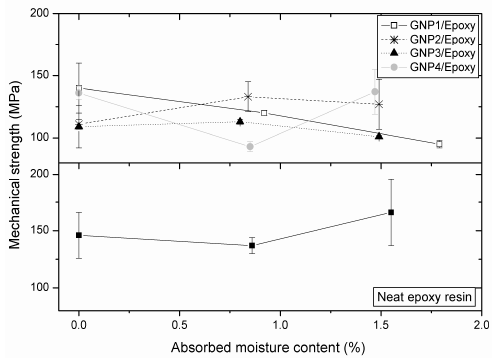
Figure 6. Variation of mechanical properties due to the water absorption.